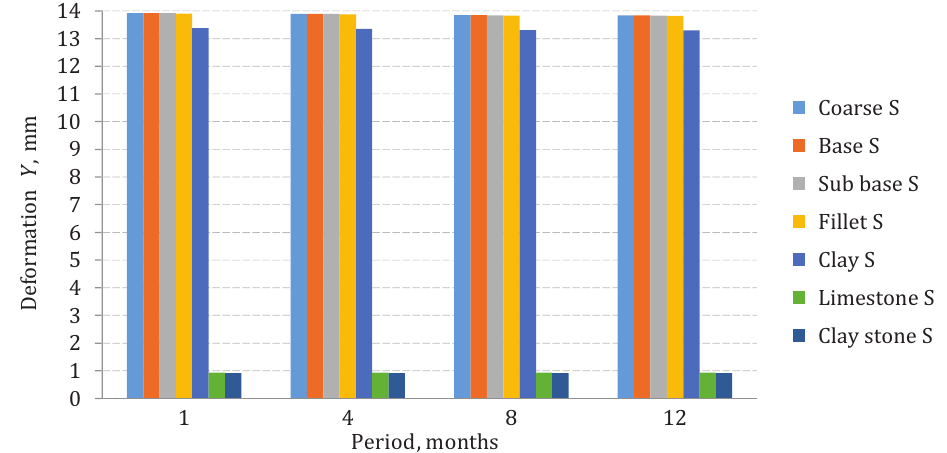
Figure 17. Vertical deformation ( y )-time changes of the layers for S type